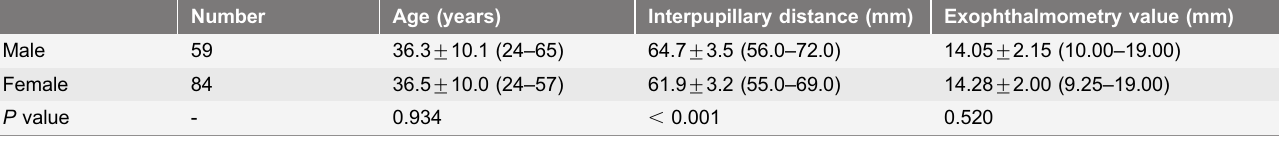
Table 4. Gender-specific measurement results and statistical comparisons in